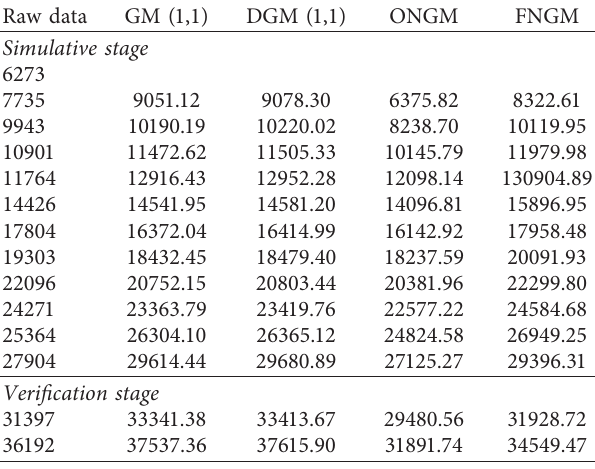
Table 4: Fitted values of raw data on China’s natural gas con- sumption by different grey models.